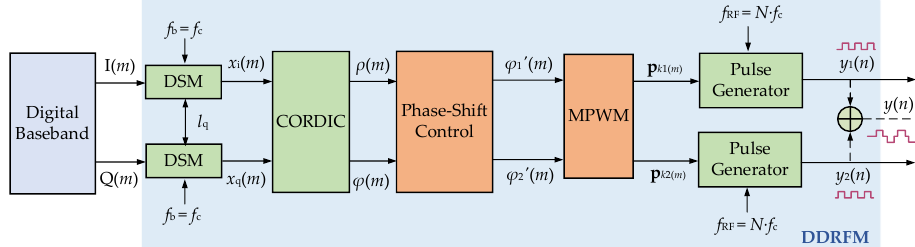
Figure 2. Structure diagram of three-level RF-PWM based on phase-shift control and MPWM. DSM module: Convert the digital baseband I( m ) and Q( m ) signals into DSM modulated signals with quantization level number l q . To obtain satisfactory in-band noise suppression, the DSM processing of I( m ) and Q( m ) is required before the CORDIC extracts amplitude-phase information. This module uses oversampling and noise shaping techniques to move the in-band noise out of band and then outputs the DSM modulated signals x i ( m ) and x q ( m ). In this case, the structure of the DSM is a second-order low pass. CORDIC module: Convert x i ( m ) and x q ( m ) to amplitude and phase information ρ ( m ) and φ ( m ). At first, normalize the complex signal synthesized by x i ( m ) and x q ( m ), and then extract the amplitude-phase information ( ρ ( m ), φ ( m )) of the normalized complex signal. Phase-shift control module: Convert ρ ( m ) and φ ( m ) into the two phase-shift signals φ 1 ′( m ) and φ 2 ′( m ). The two decomposed signals with the phases φ 1 ′( m ) and φ 2 ′( m ) and the amplitude of 1/2 can be obtained by derivation based on ρ ( m ) and φ ( m ). MPWM module: Map φ 1 ′( m ) and φ 2 ′( m ) to the two two-level pulse sequences p k 1 ( m ) and p k 2 ( m ). Input φ 1 ′( m ) and φ 2 ′( m ) into the preset LUT for mapping lookup, respectively, and get the two two-level output pulse sequences p k 1 ( m ) and p k 2 ( m ). Pulse generator: Convert p k 1 ( m ) and p k 2 ( m ) into the two-level RF pulse waveforms y 1 ( n ) and y 2 ( n ), respectively. The pulse sequences corresponding to all amplitude-phase information are sequentially spliced into the two-level pulse signals y 1 ( n ) and y 2 ( n ). Adder: Synthesize the two-level y 1 ( n ) and y 2 ( n ) into the desired three-level RF-PWM signal y ( n ). Here, y ( n ) is used for simulation experiments to analyze the performance of the proposed scheme, and is not the real output of DDRFM.